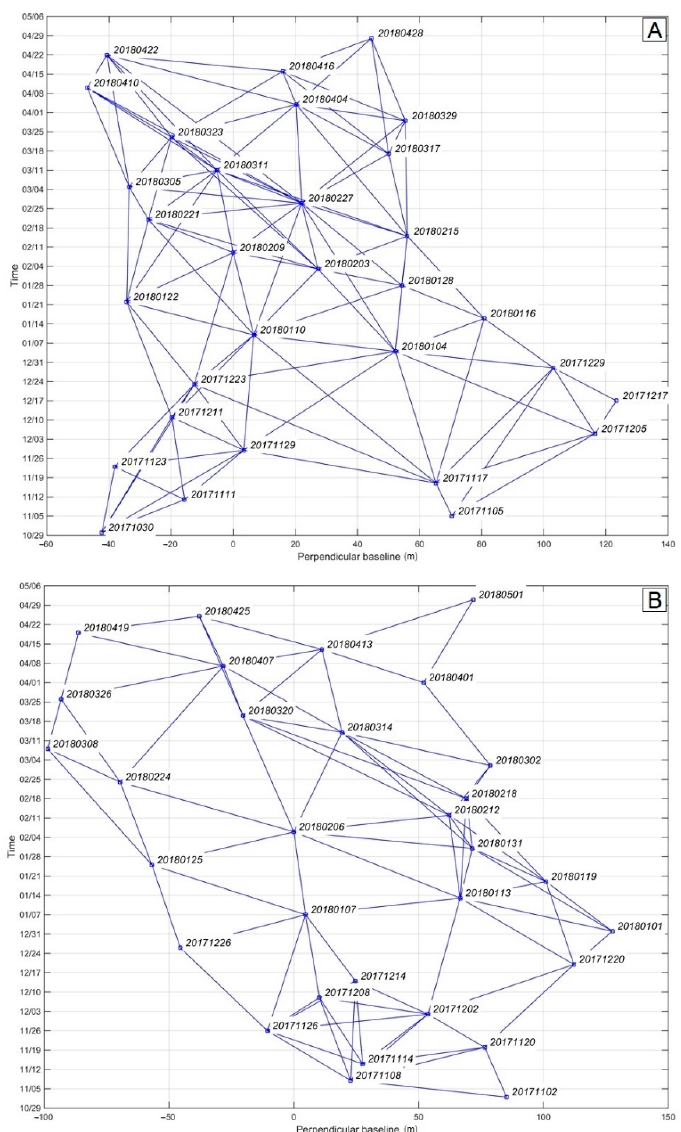
Figure 3. The configuration of interferograms used in the investigation on a time plot, with the perpendicular baseline for Sentinel-1 satellite acquisitions in ascending ( A ) and descending ( B ) mode.